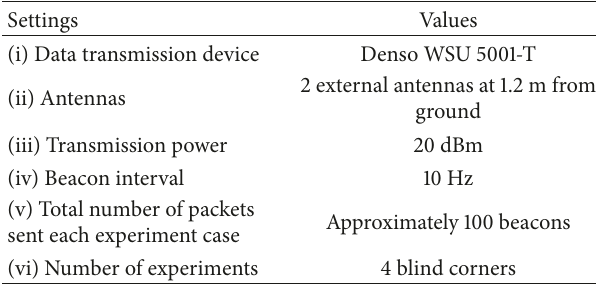
Table 2: The experiment settings.